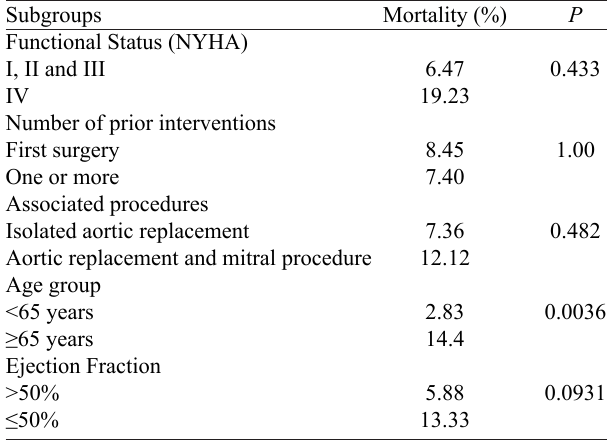
Table 1. Subgroups in hospital mortality.